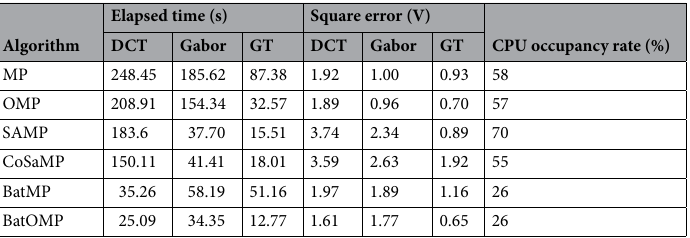
Table 3. Quantitative analysis of experimental results.